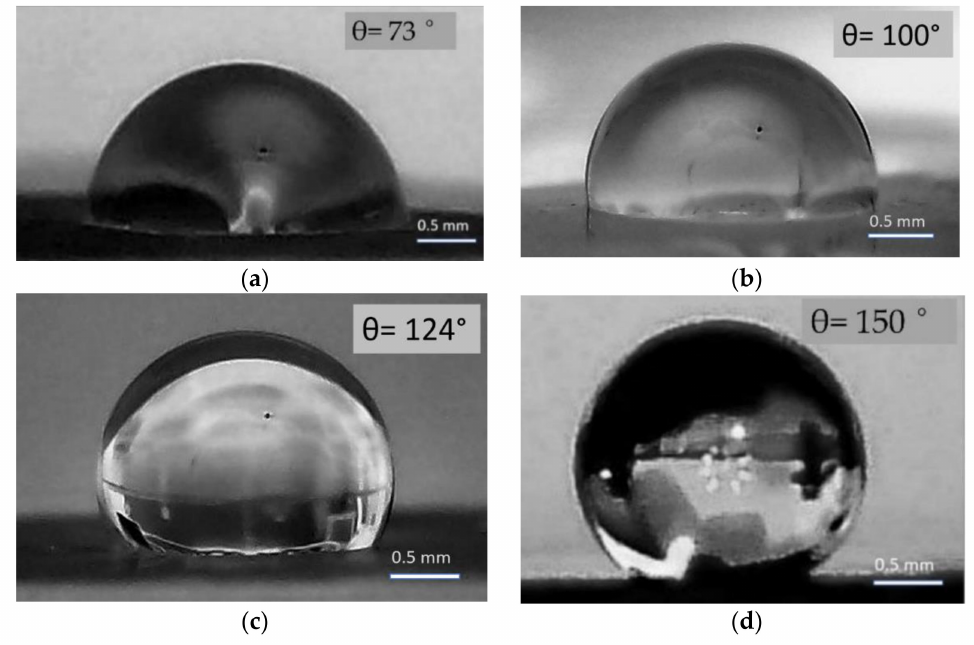
Figure 8. Optical images of the shape of a water drop on the surface of the samples: type I ( a ), II ( b ), III ( c , d